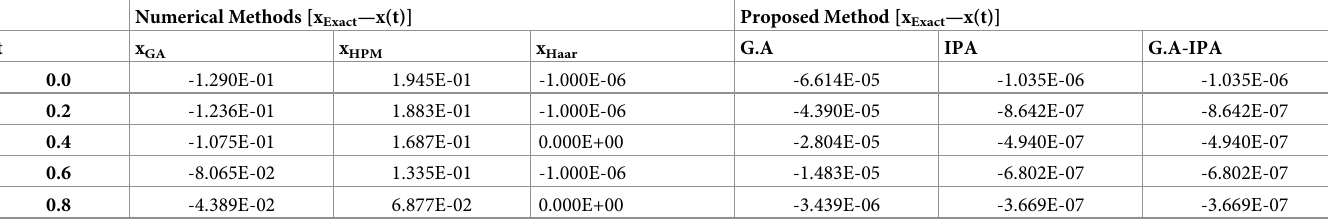
Table 16. Comparison of absolute errors between numerical methods and proposed method for δ = 0.6. Numerical Methods [x Exact —x(t)]